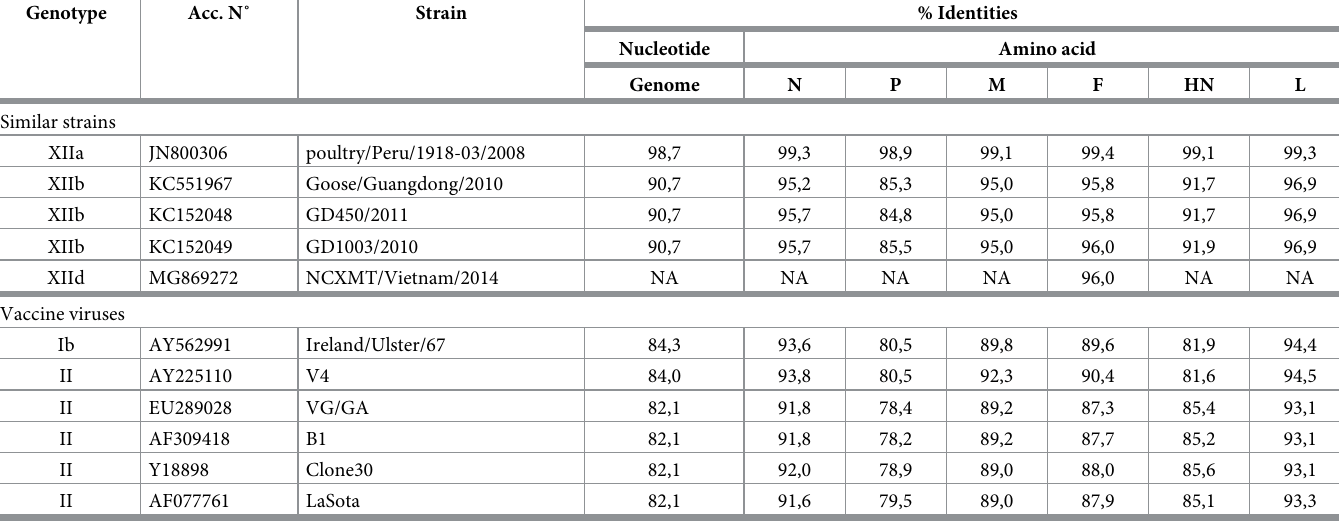
Table 1. Sequence identities between PP2011 and other representative NDV